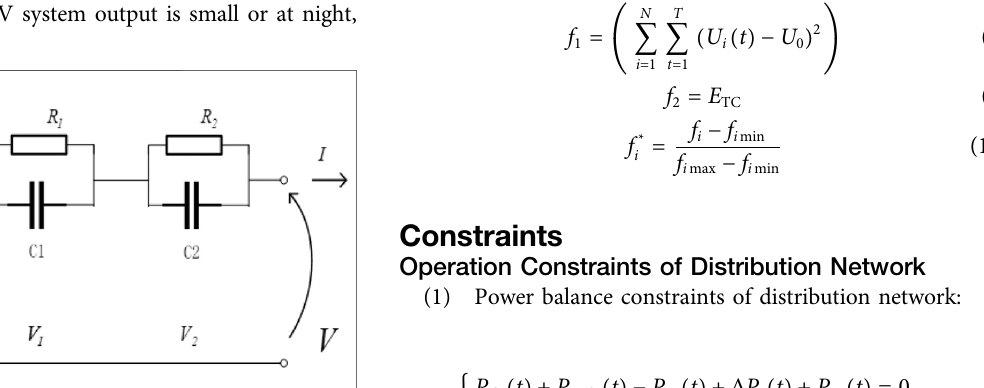
FIGURE 2 | Detailed equivalent circuit diagram of the energy storage